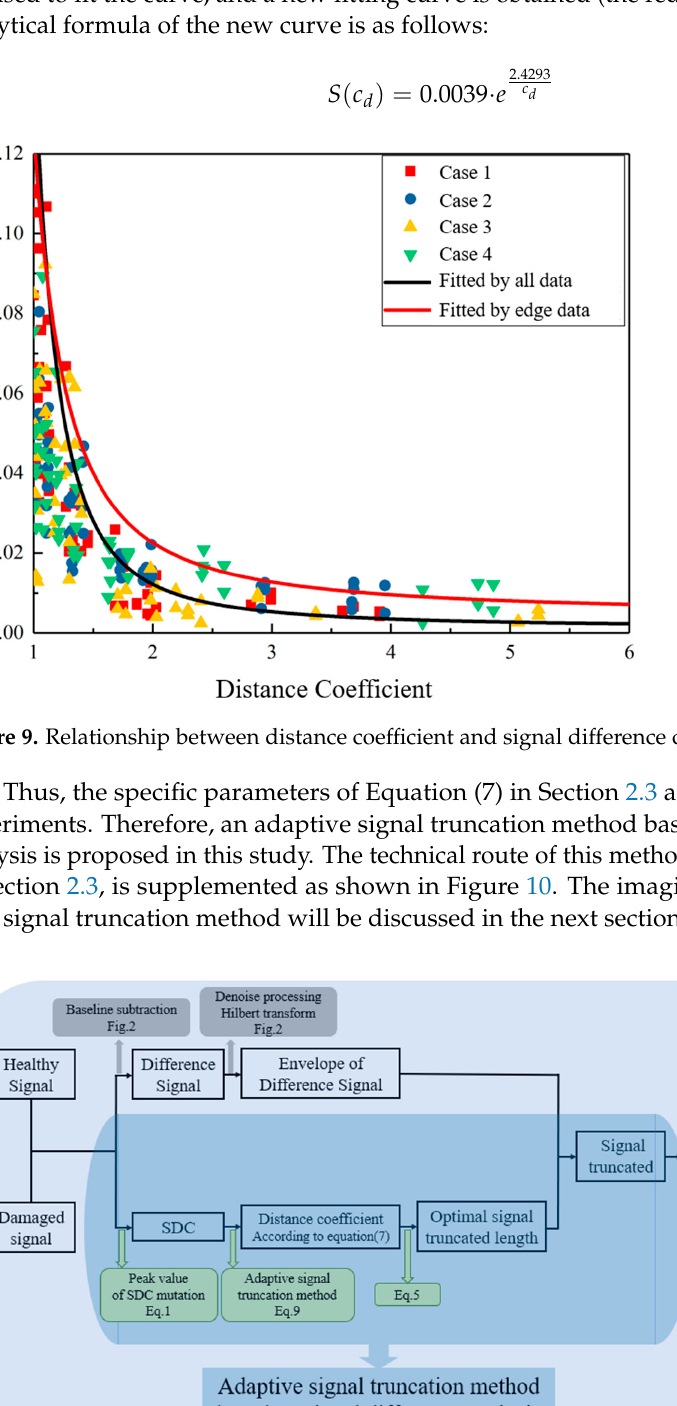
Figure 10. Adaptive signal truncation method based on signal difference analysis.